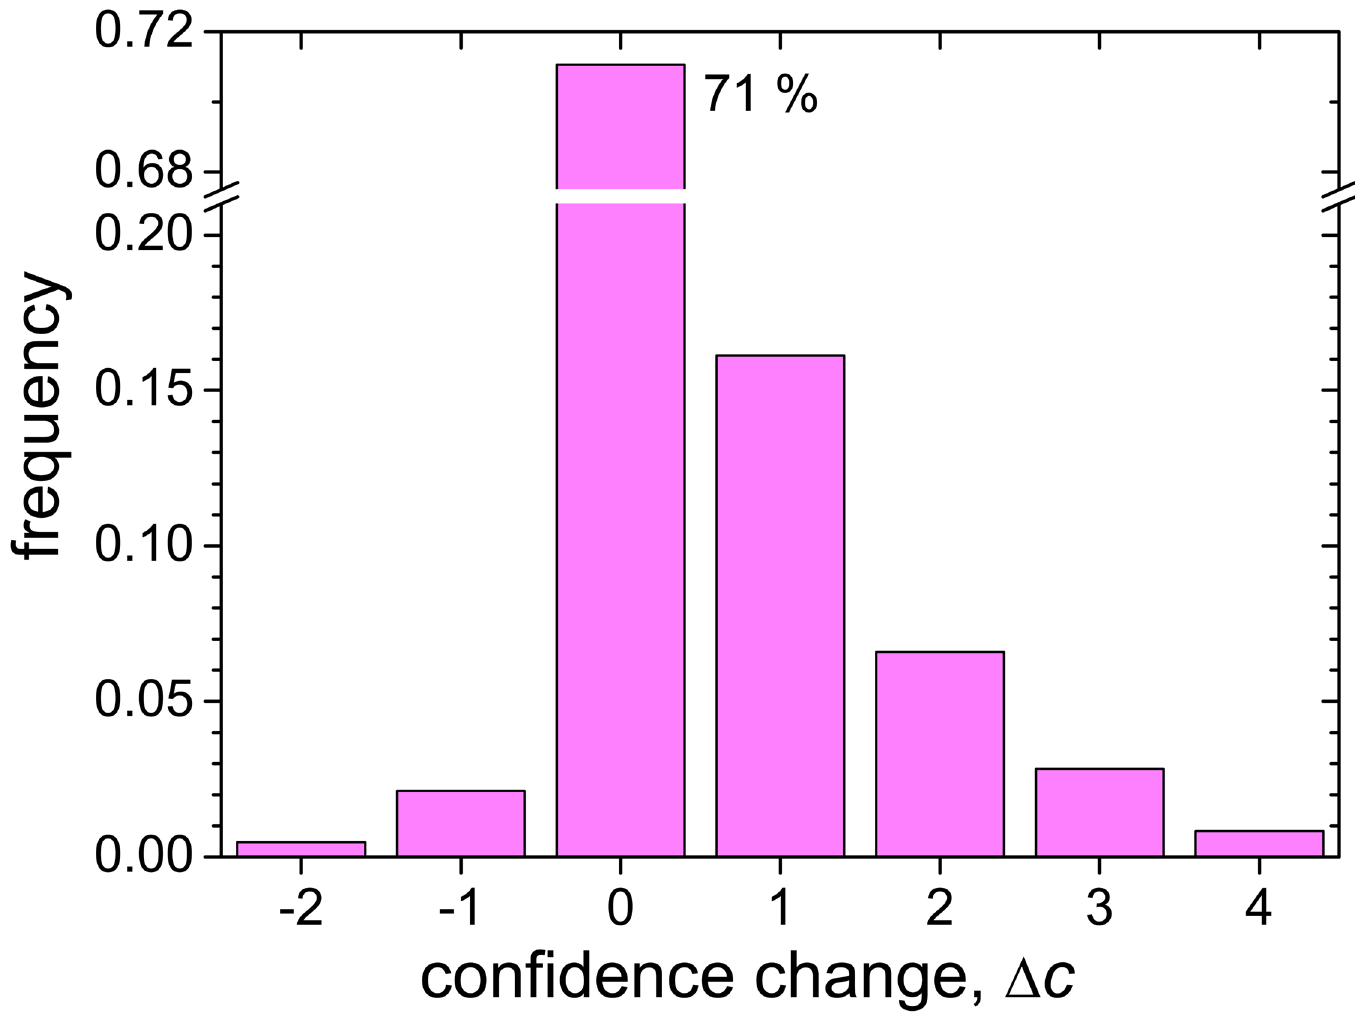
Fig 3. Distribution of changes in the confidence level. The histogram shows the frequencies for the confidence change between rounds, Δ c = c 0 − c , for class A questions (see also S2 Table). The frequency is exactly equal to zero for Δ c < − 2 and Δ c > 4. By far, the most frequent value is Δ c = 0, with about 71% of the cases. The distribution is biased towards positive values, with a total of 26% and 3% of the cases for Δ c > 0 and Δ c < 0,